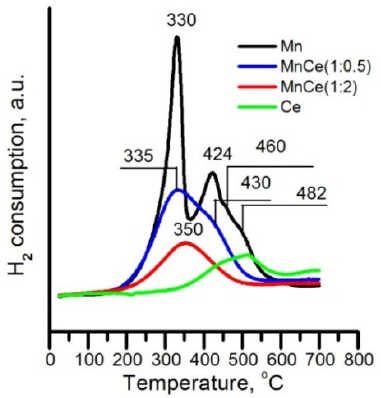
Figure 10. TPR spectra of single- and bi-component catalysts.